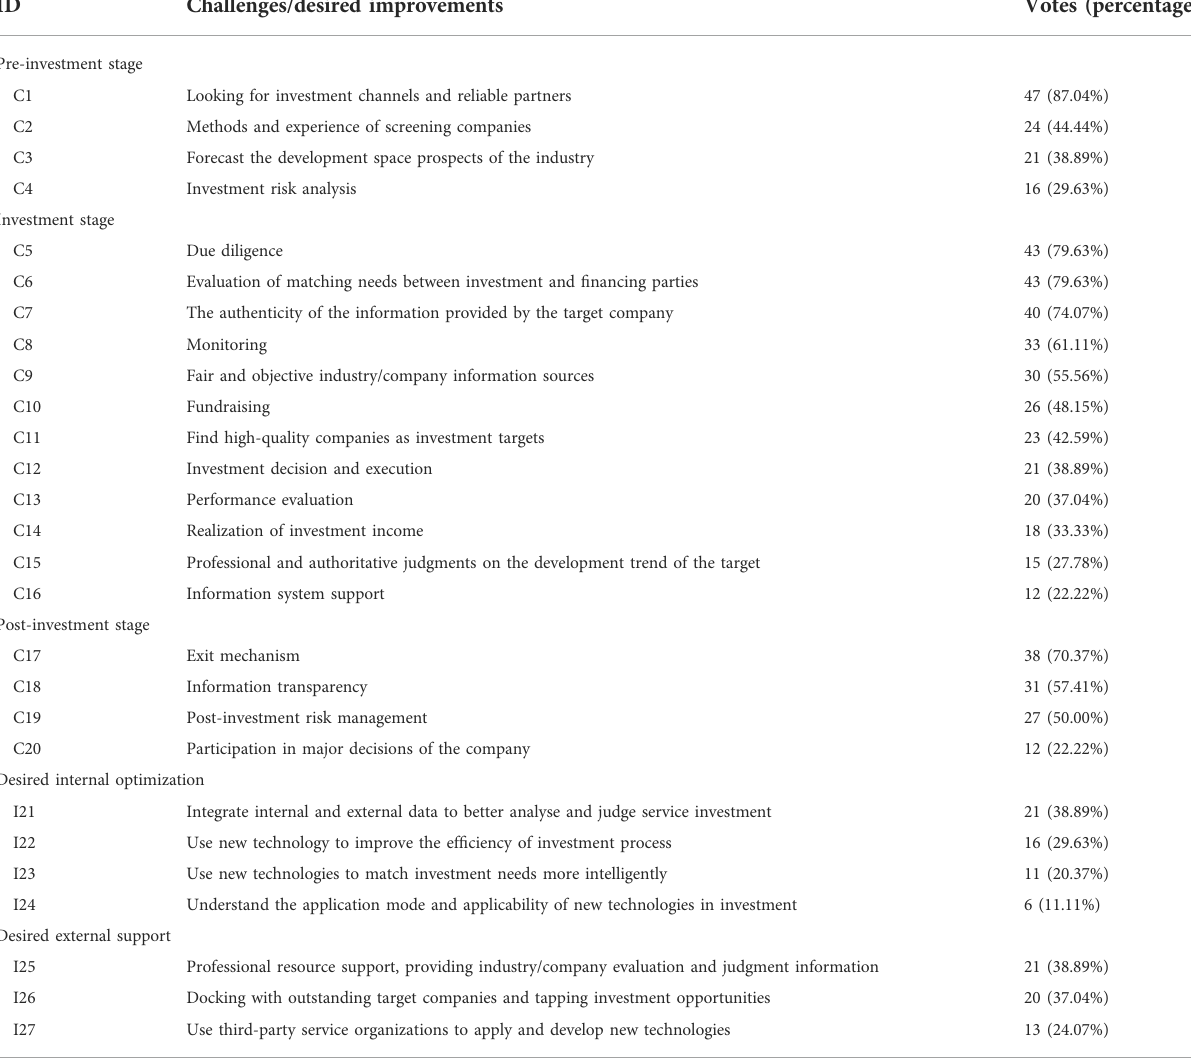
TABLE 3 Votes of challenges and desired improvements from